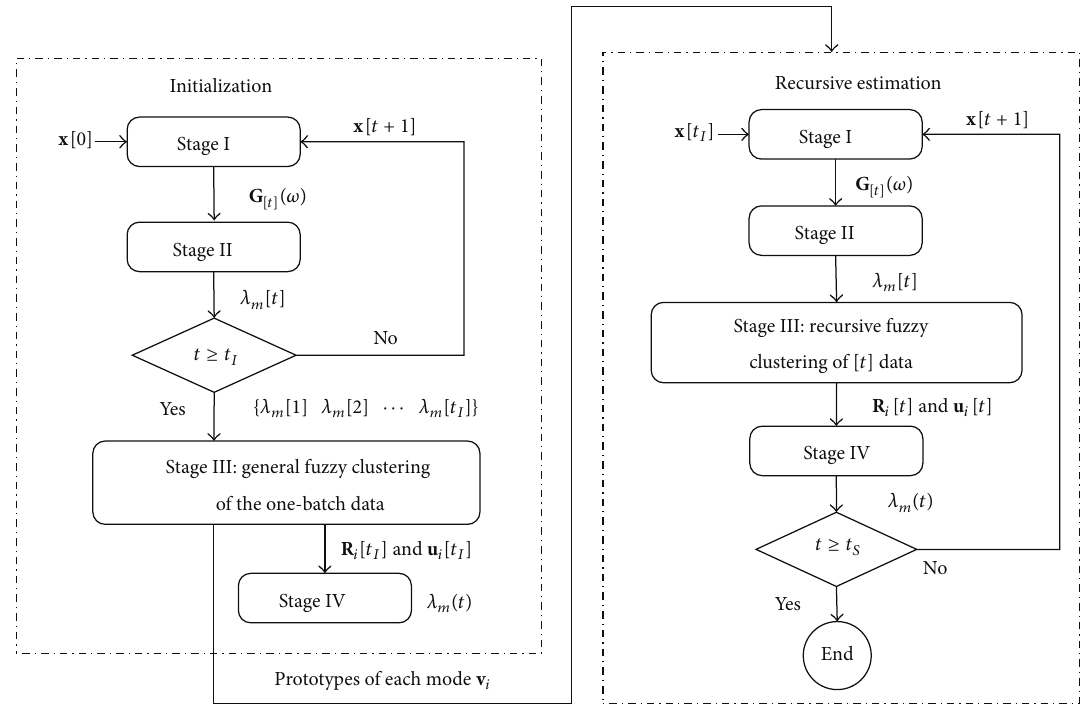
Figure 2: Detail flowchart of the